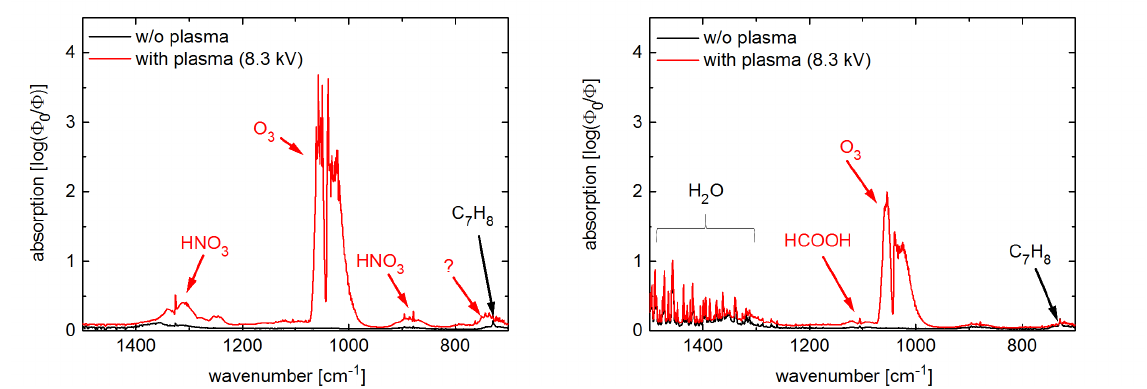
Figure 5: Samples of the infrared-spectra of the analyzed gas mixtures without plasma (black lines) and with plasma (frequency 1 kHz, operating voltage 8.3 kV, red lines) under dry (left) and wet conditions